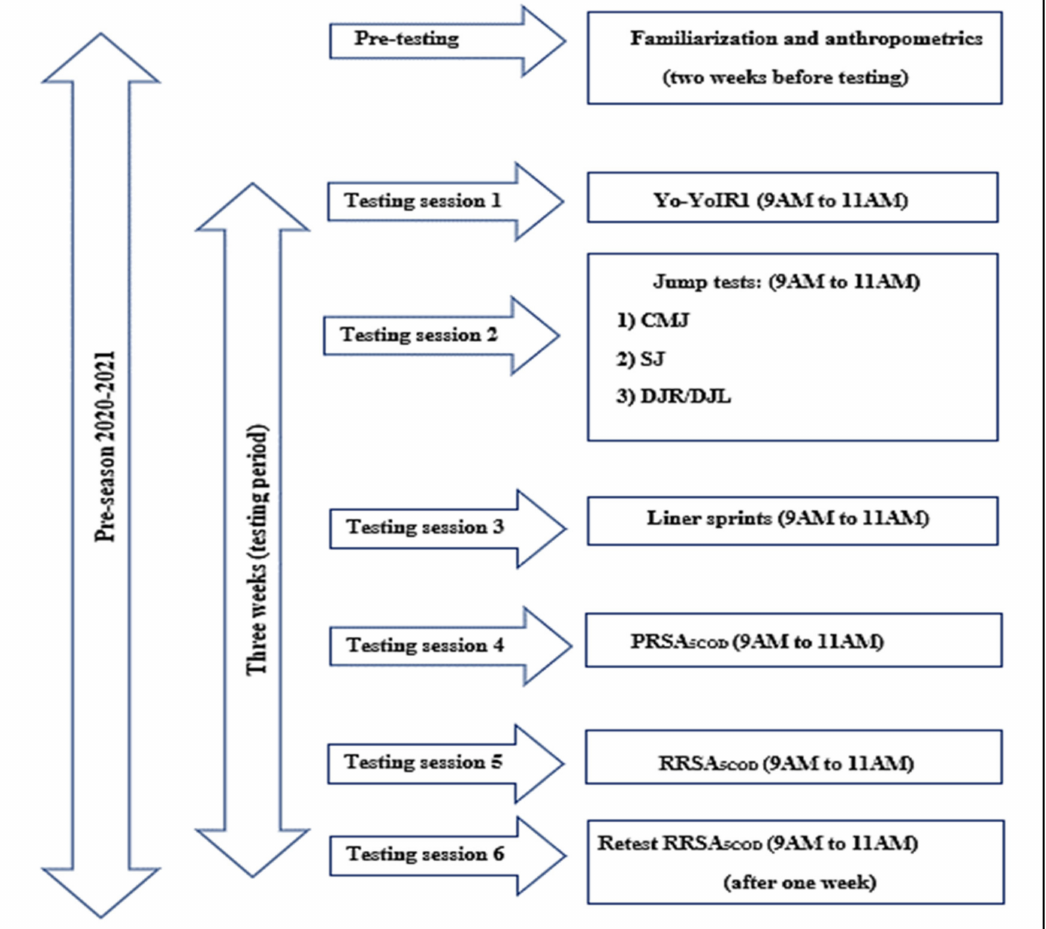
Figure 1. Experimental protocol. Legend: SJ: squad jump test, CMJ: countermovement jump test, DJR: single leg drop jump test ( right ), DRL; single leg drop jump ( left ); Yo-Yo IR1: Yo-Yo intermittent recovery test level